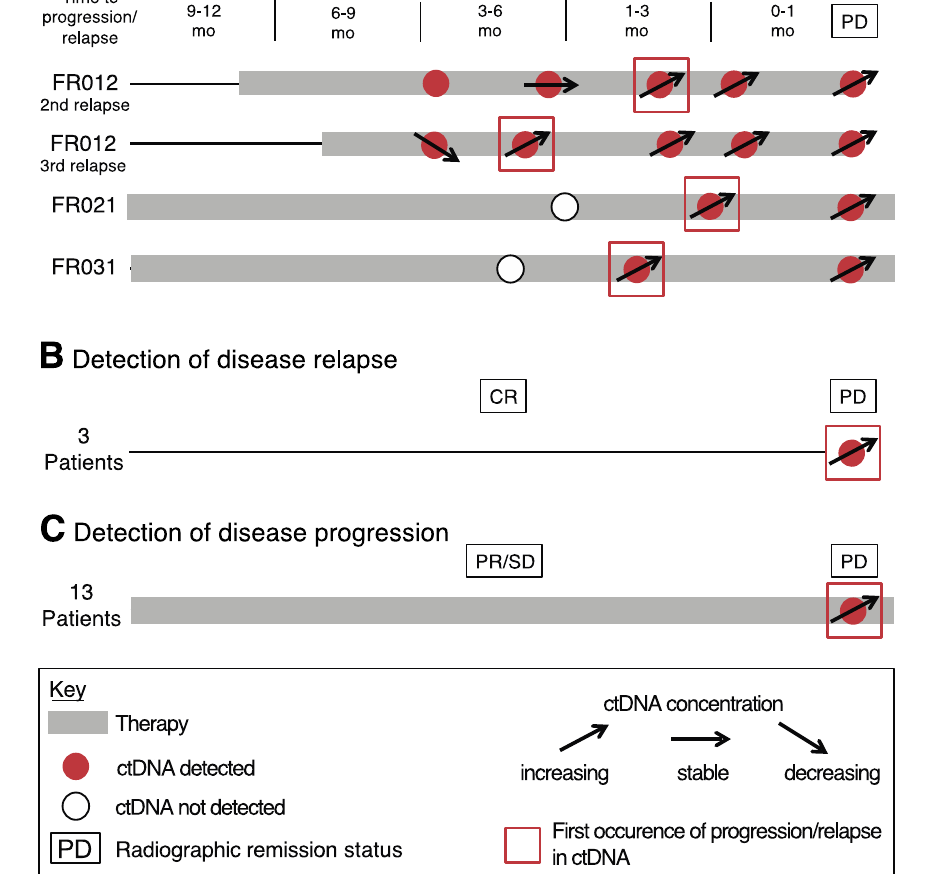
Figure 1. Disease progression mirrored by ctDNA concentrations. ( A ) Patient data demonstrating ctDNA detection before radiographic disease progression. ( B , C ) Accumulative patient data showing ctDNA detection at disease relapse after a complete response ( B ) or an increase of ctDNA levels at disease progression ( C ). Open circle, ctDNA not detected; red circle, ctDNA detected; black ascending arrow, increasing ctDNA levels; black descending arrow, decreasing ctDNA levels; black horizontal arrow, stable ctDNA levels; red square, first appearance of ctDNA increase before radiographic disease progression; black rectangle, radiographic remission status; grey bar, treatment; CR, complete response; ctDNA, circulating tumor DNA; mo, months; PD, progressive disease; PR, partial response; SD, stable disease.